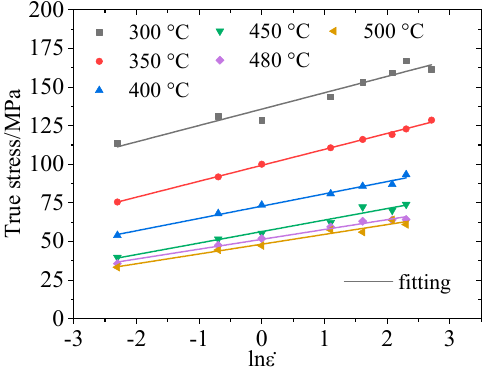
. ε . Figure 6. The fitting curves for σ − 𝑙𝑛𝜀(cid:4662) .